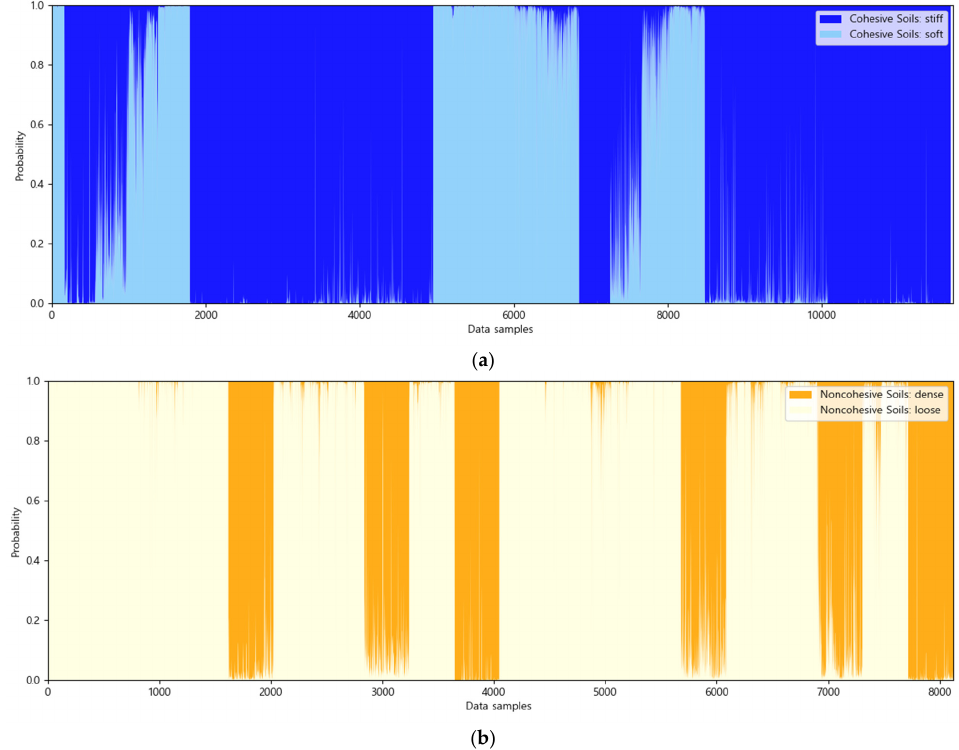
Table 11. Evaluation of classification performance (step 2) for EPB TBM datasets.